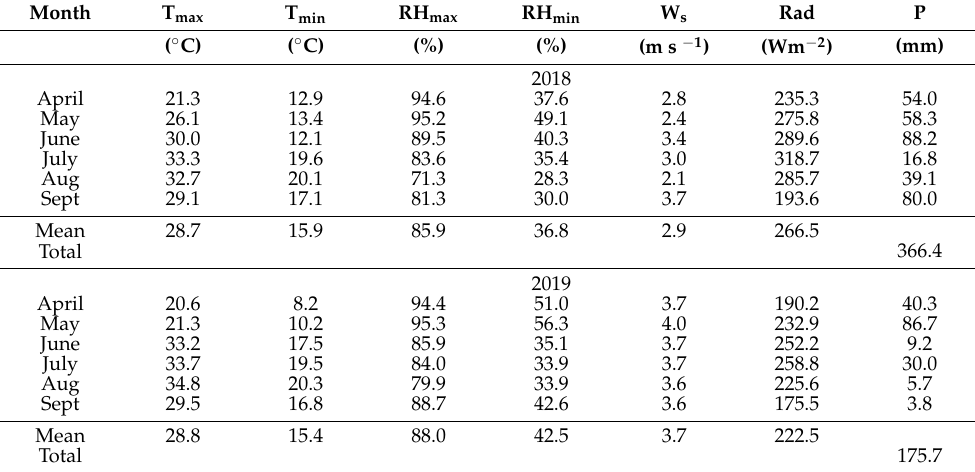
Table 1. Monthly mean maximum and minimum temperatures (T max , T min ), relative air humidity (RH max and RH min ), wind speed (W s ), radiation (Rad) and total precipitation (P) during 2018 and 2019